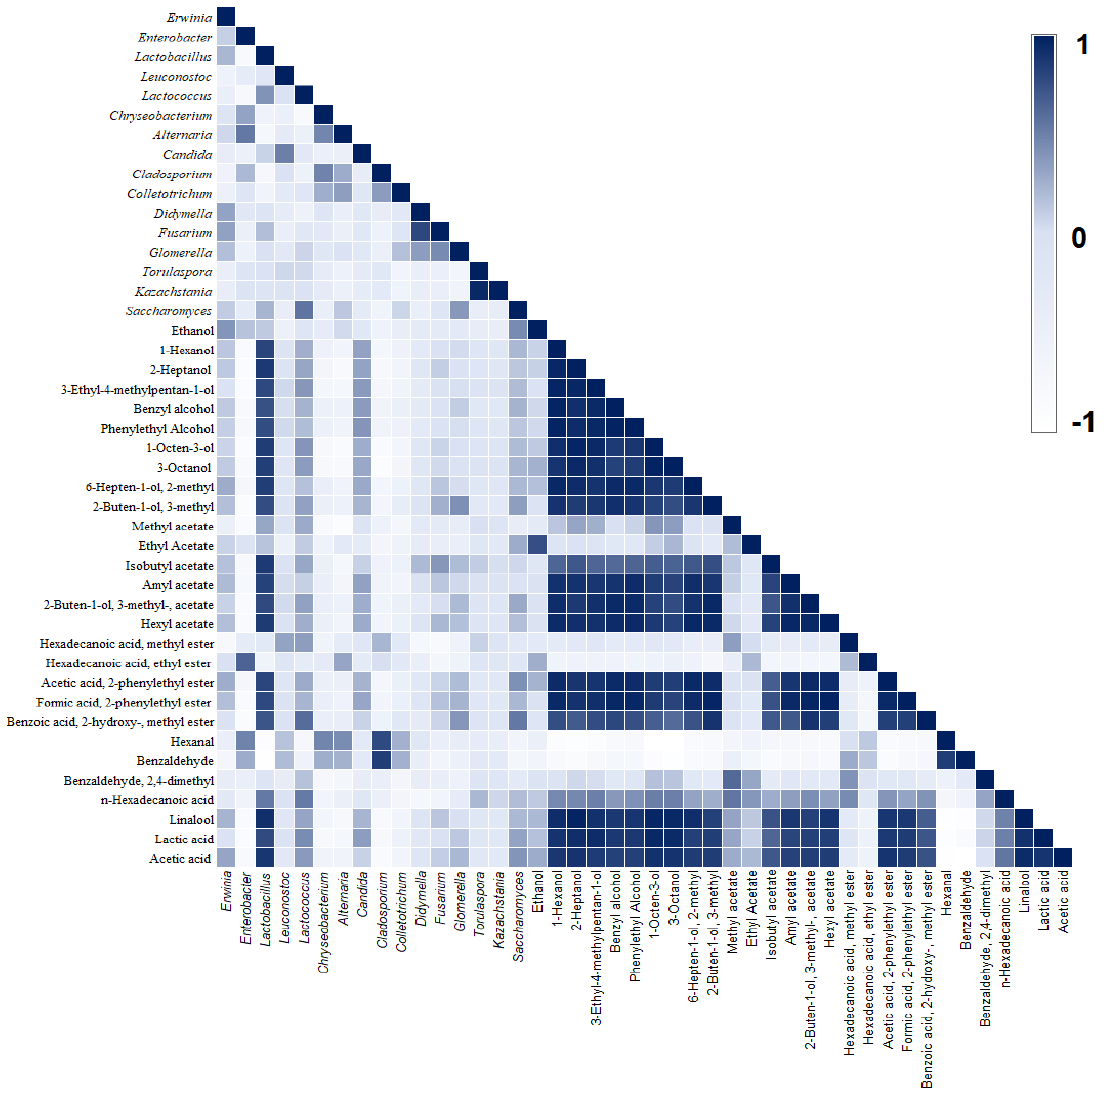
Figure 3. Pearson correlation matrix of the main microbial groups and volatile compounds identi- fied.